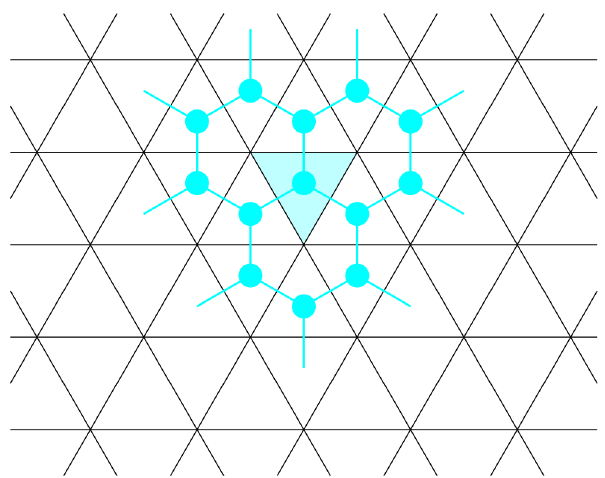
Figure 3. The figure shows a piece of the equilateral triangle tiling (cid:54) of the plane. The turquoise vertices and edges represent the dual graph of the tiling as defined in Definition